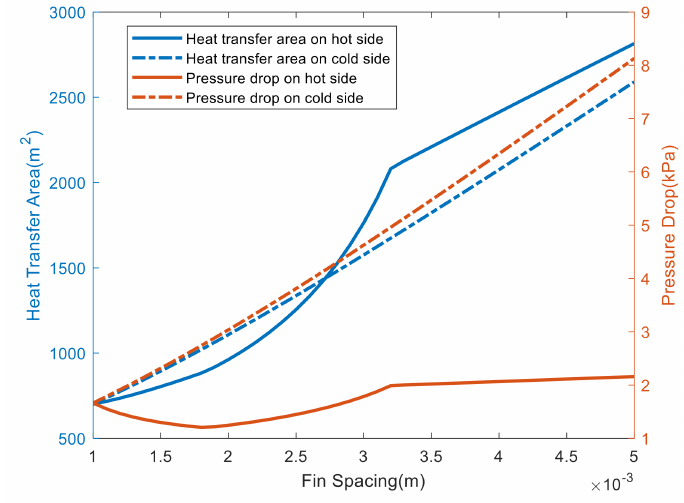
Figure 8. Effect of fin spacing on heat transfer area and pressure drop of PFHE.